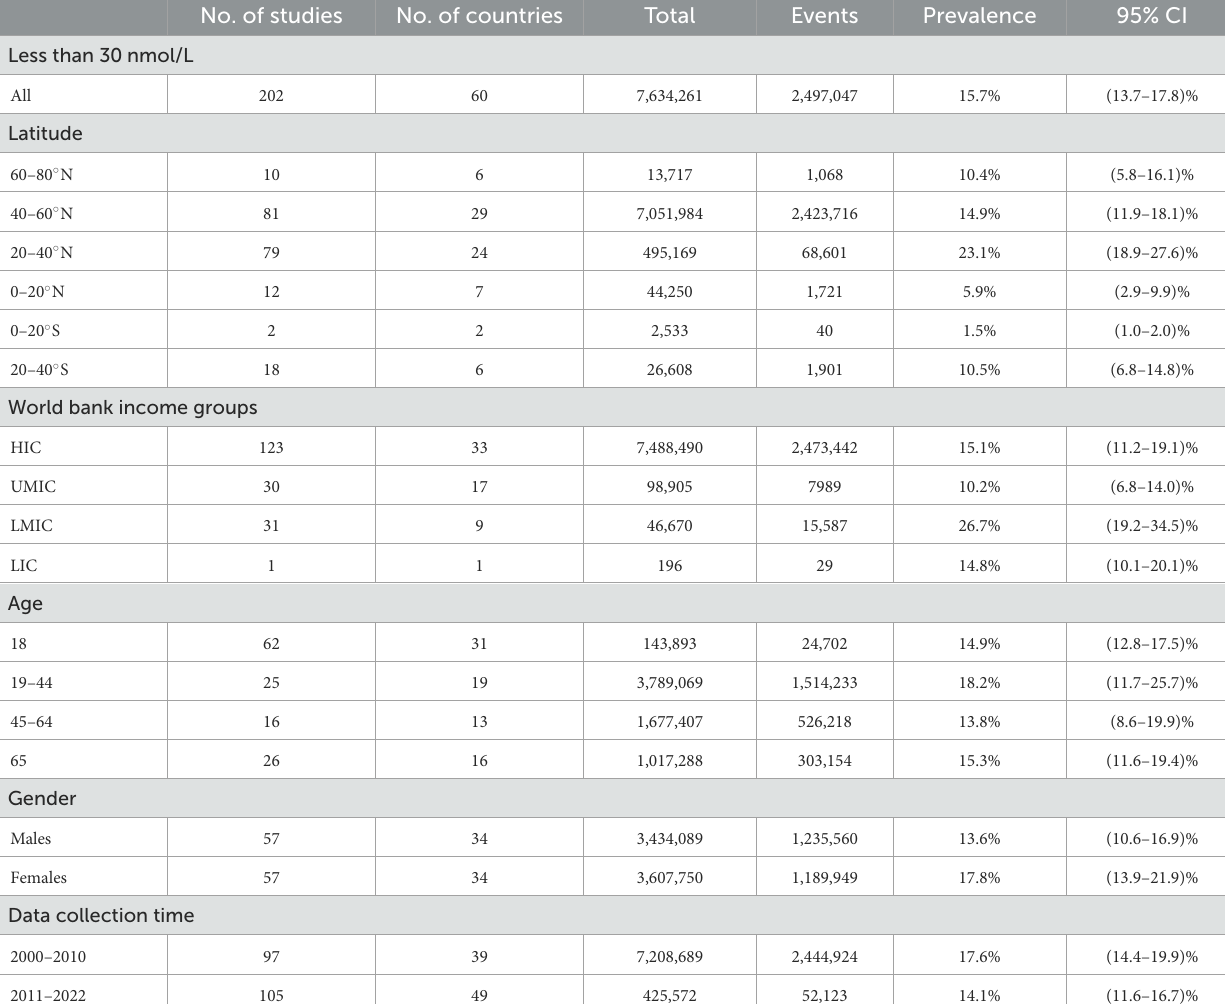
TABLE 1 The prevalence of serum 25-hydroxyvitamin D levels < 30 nmol/l.